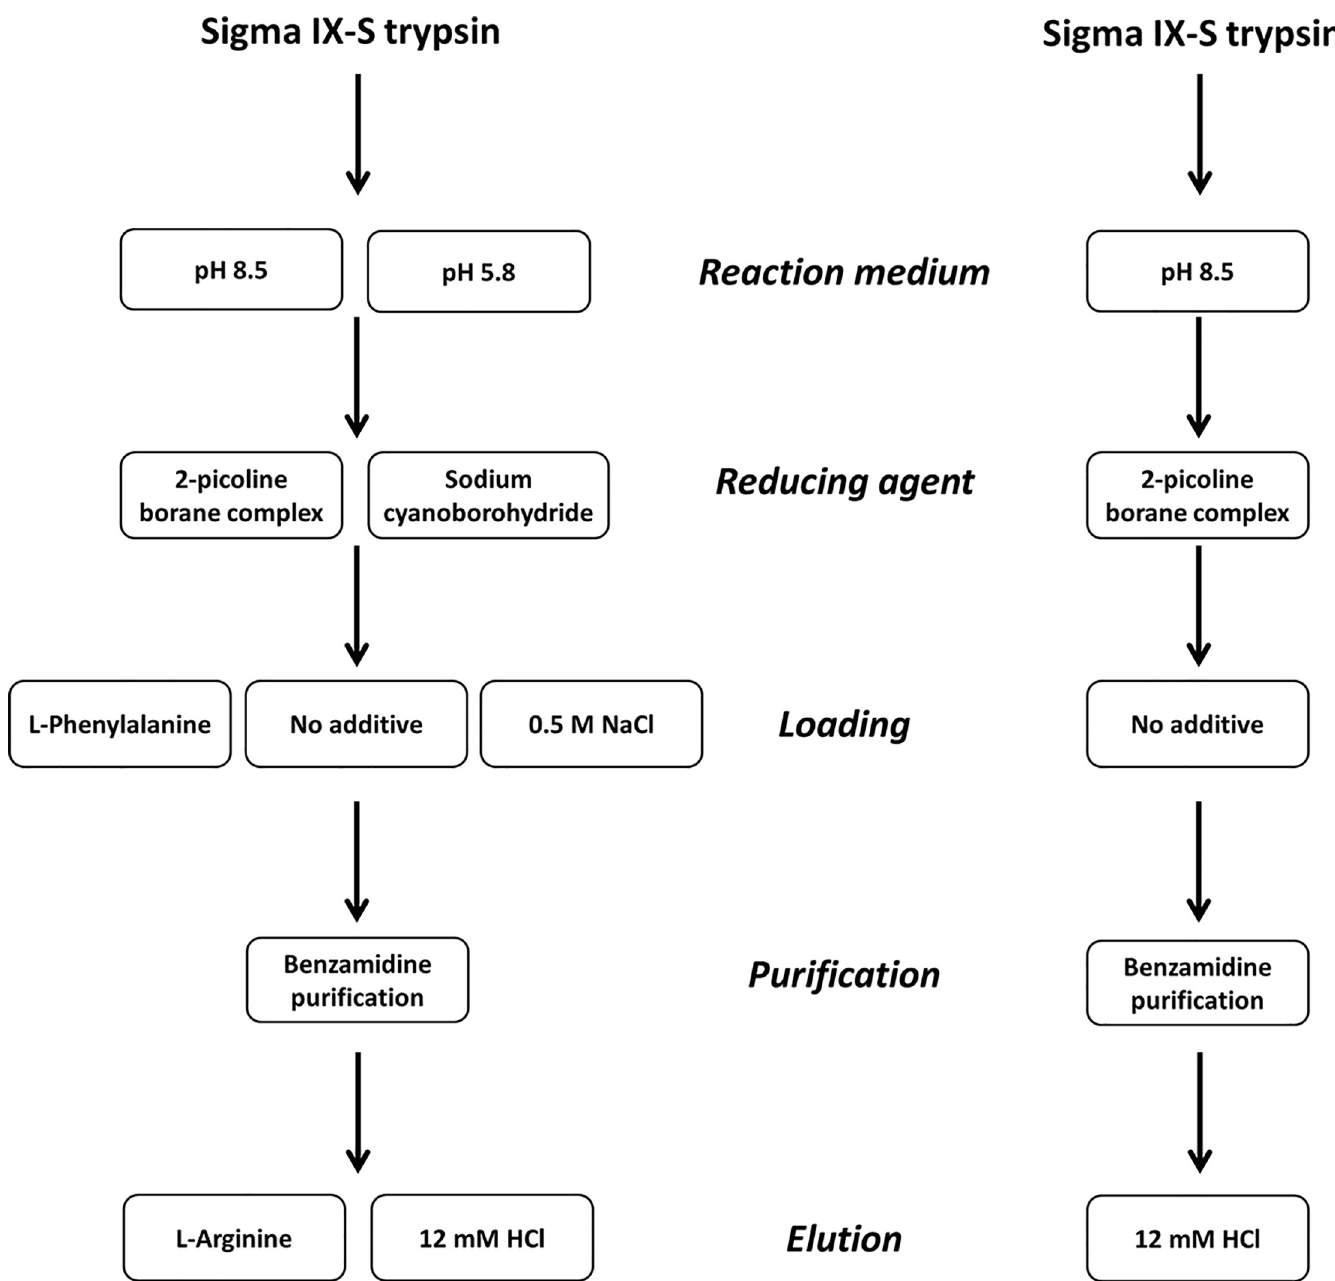
Fig 1. Trypsin preparation workflow. (A) The general workflow for preparation of purified, stabilized trypsin along with different parameters that were evaluated. (B) The final workflow after evaluation.